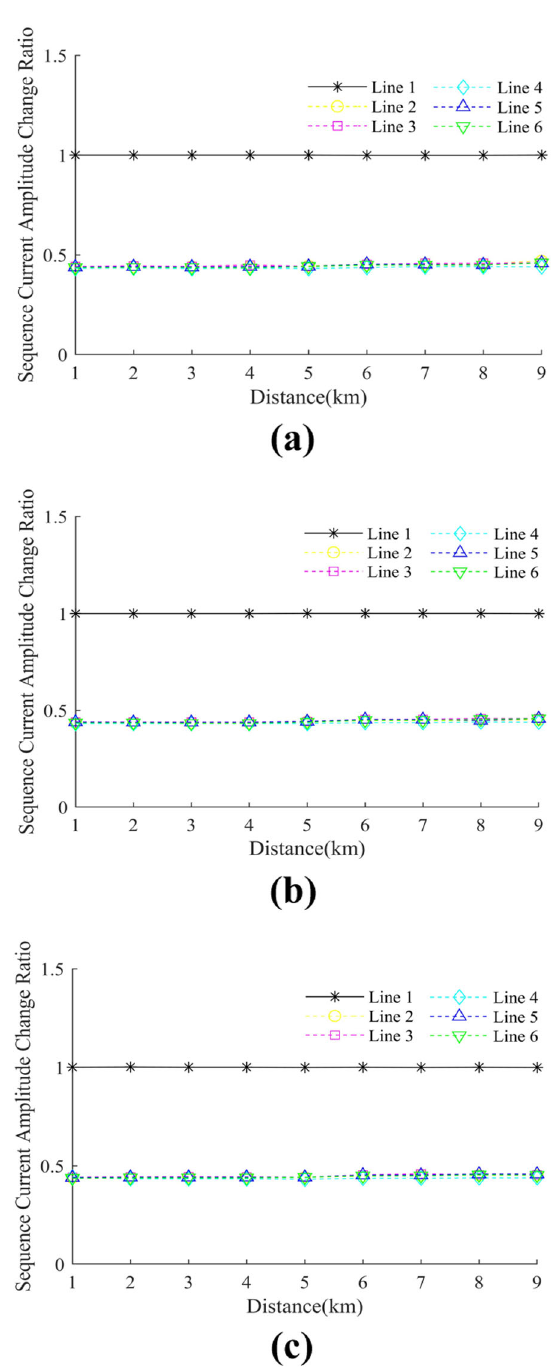
Fig. 7 Positive and negative sequence current amplitude change ratio variation with fault location (a) Ungrounded (b) Arc suppression coil grounded (c) Low resistance grounded